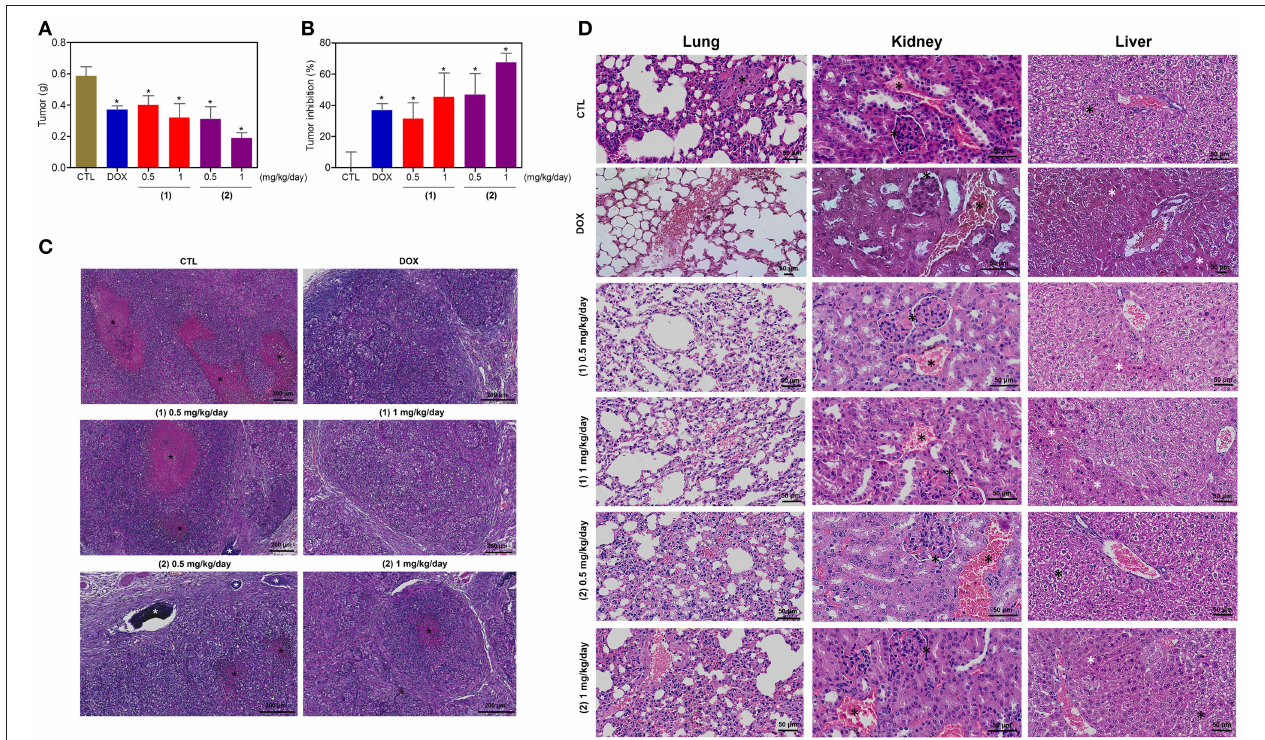
FIGURE 12 | In vivo antitumor activity of ruthenium complexes containing heterocyclic thioamidates in C.B-17 SCID mice with HepG2 cell xenografts. (A) Quantification of the tumor weight (g). (B) Quantification of the tumor inhibition (%). Data are presented as the mean ± S.E.M. of 8–10 animals. * P < 0.05 compared with the negative control, as determined by ANOVA followed by the Student-Newman-Keuls test. (C) Representative histological analysis of the tumors that were stained with hematoxylin and eosin and analyzed by light microscopy. The areas of necrosis and dystrophic calcification are represented by black and white asterisks, respectively. (D) Representative histological analysis of the lungs, kidneys and livers that were stained with hematoxylin and eosin and analyzed by light microscopy. Black asterisks represent metastasis (lung), the thickening of the basal membrane of the renal glomerulus with decreased urinary space or vascular congestion (kidney) and hydropic degeneration (liver). White asterisks represent the coagulation necrosis of hepatic cells. The negative control (CTL) was treated with the vehicle (5% DMSO) that was used to solubilize and dilute the complexes, and doxorubicin (DOX, 0.3 mg/kg/day) was used as the positive control. Beginning 1 day after tumor implantation, the animals were treated via an intraperitoneal route for 21 consecutive